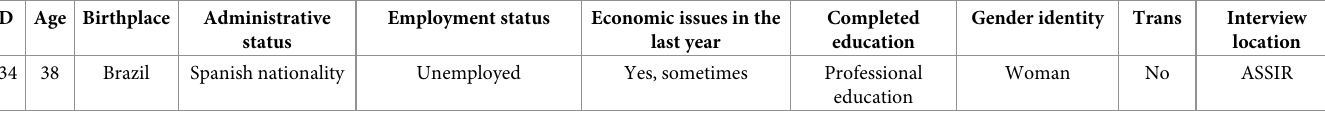
women (5.6% and 3.6% respectively).